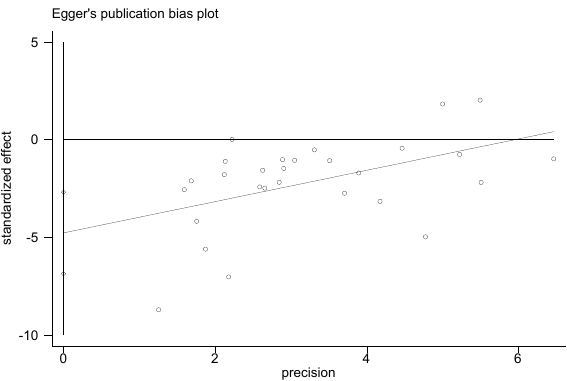
Figure 12. Egger’s test for evaluating the publication bias of cIMT.